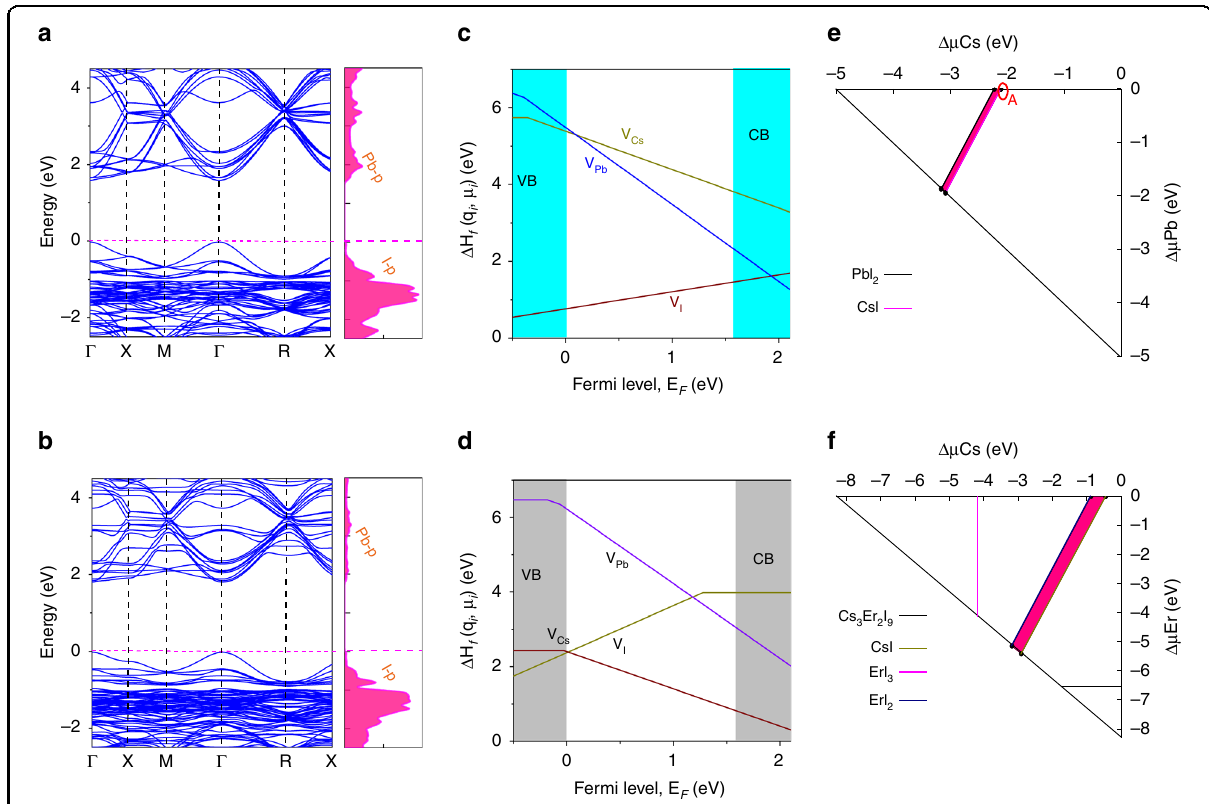
Fig. 3 Density functional theory calculations of CsPbI 3 and CsPbI 3 :Er 3 + PQDs. a , b Band structure and DOS of CsPbI 3 and CsPbI 3 :Er 3 + PQDs. c , d Calculated formation energy of intrinsic vacancy defects for Cs, Pb and I (labeled as VCs, VPb and VI) of CsPbI 3 and CsPbI 3 :Er 3 + PQDs. e , f Calculated phase diagrams of cubic CsPbI 3 (8 fu/cell) and CsErI 3 (8 fu/cell) with internal symmetry breaking. The pink polygons indicate the stable regions of the single-phase of cubic CsPbI 3 and CsErI